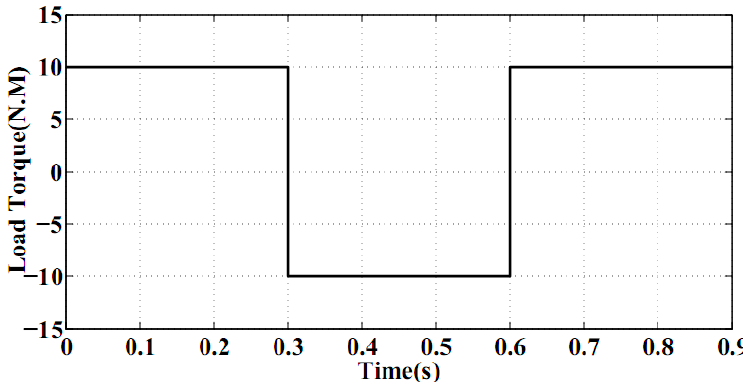
Figure 17. The step load applied to the motor.